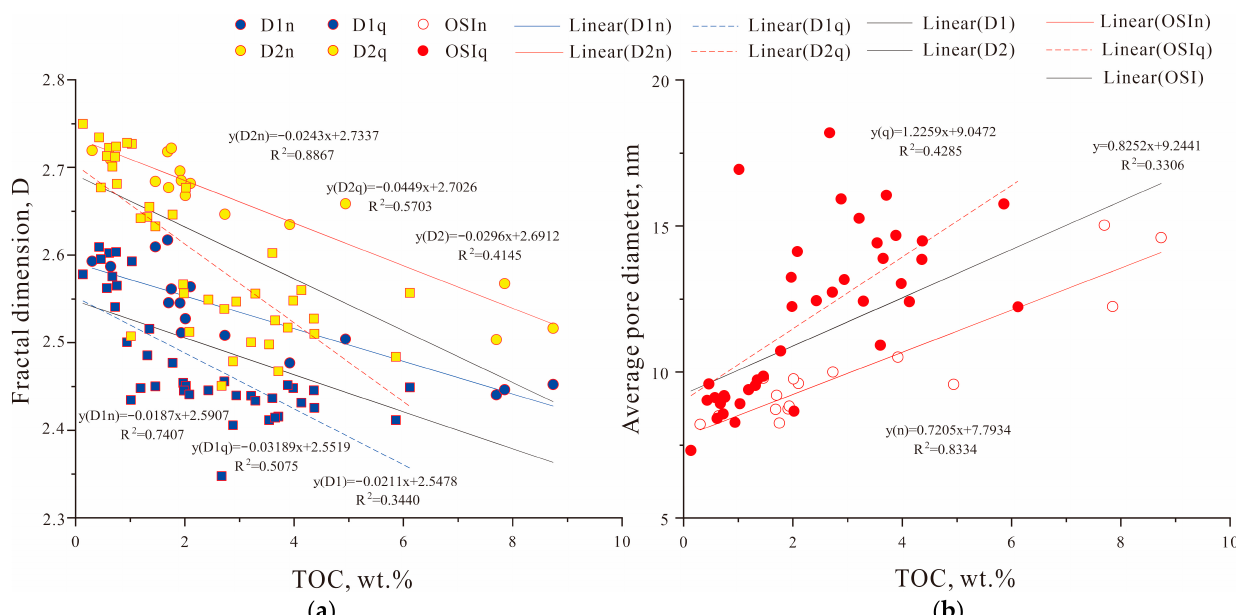
Figure 10. ( a ) Relationship between TOC content and fractal dimensions D1 and D2 of K 2 n 1+2 and K 2 q shale samples. ( b ) Relationship between TOC content and average pore diameter of K 2 n 1+2 and K 2 q shale samples. The K 2 q compared to